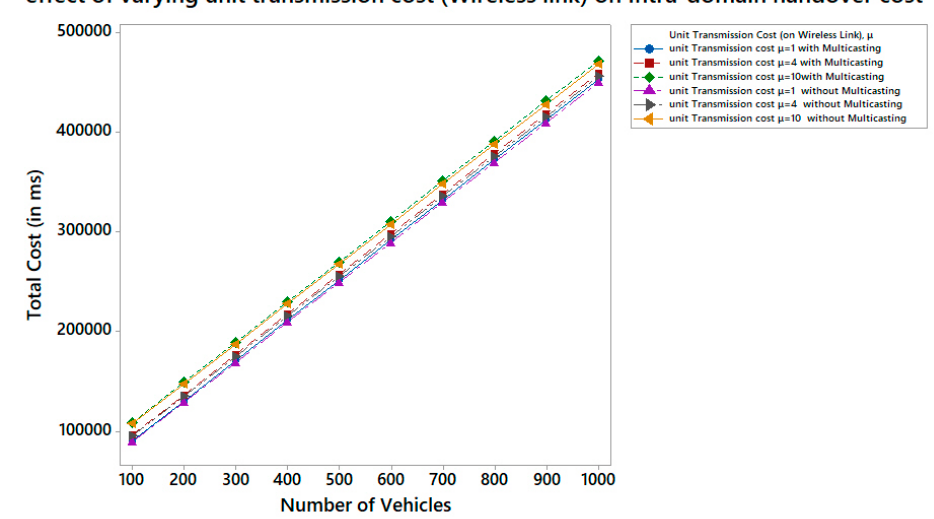
Figure 8. Effect of varying unit transmission cost (wireless link) on intra-domain handoff .